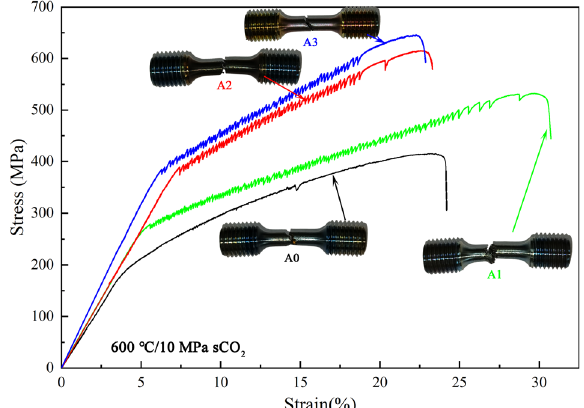
Fig. 1 SSRT stress – strain curves of different materials in sCO 2 . (A0: 0Al-0.6Nb, A1: 2.5Al-0.6Nb, A2: 3.5Al-0.6Nb, A3: 3.5Al-1Nb).